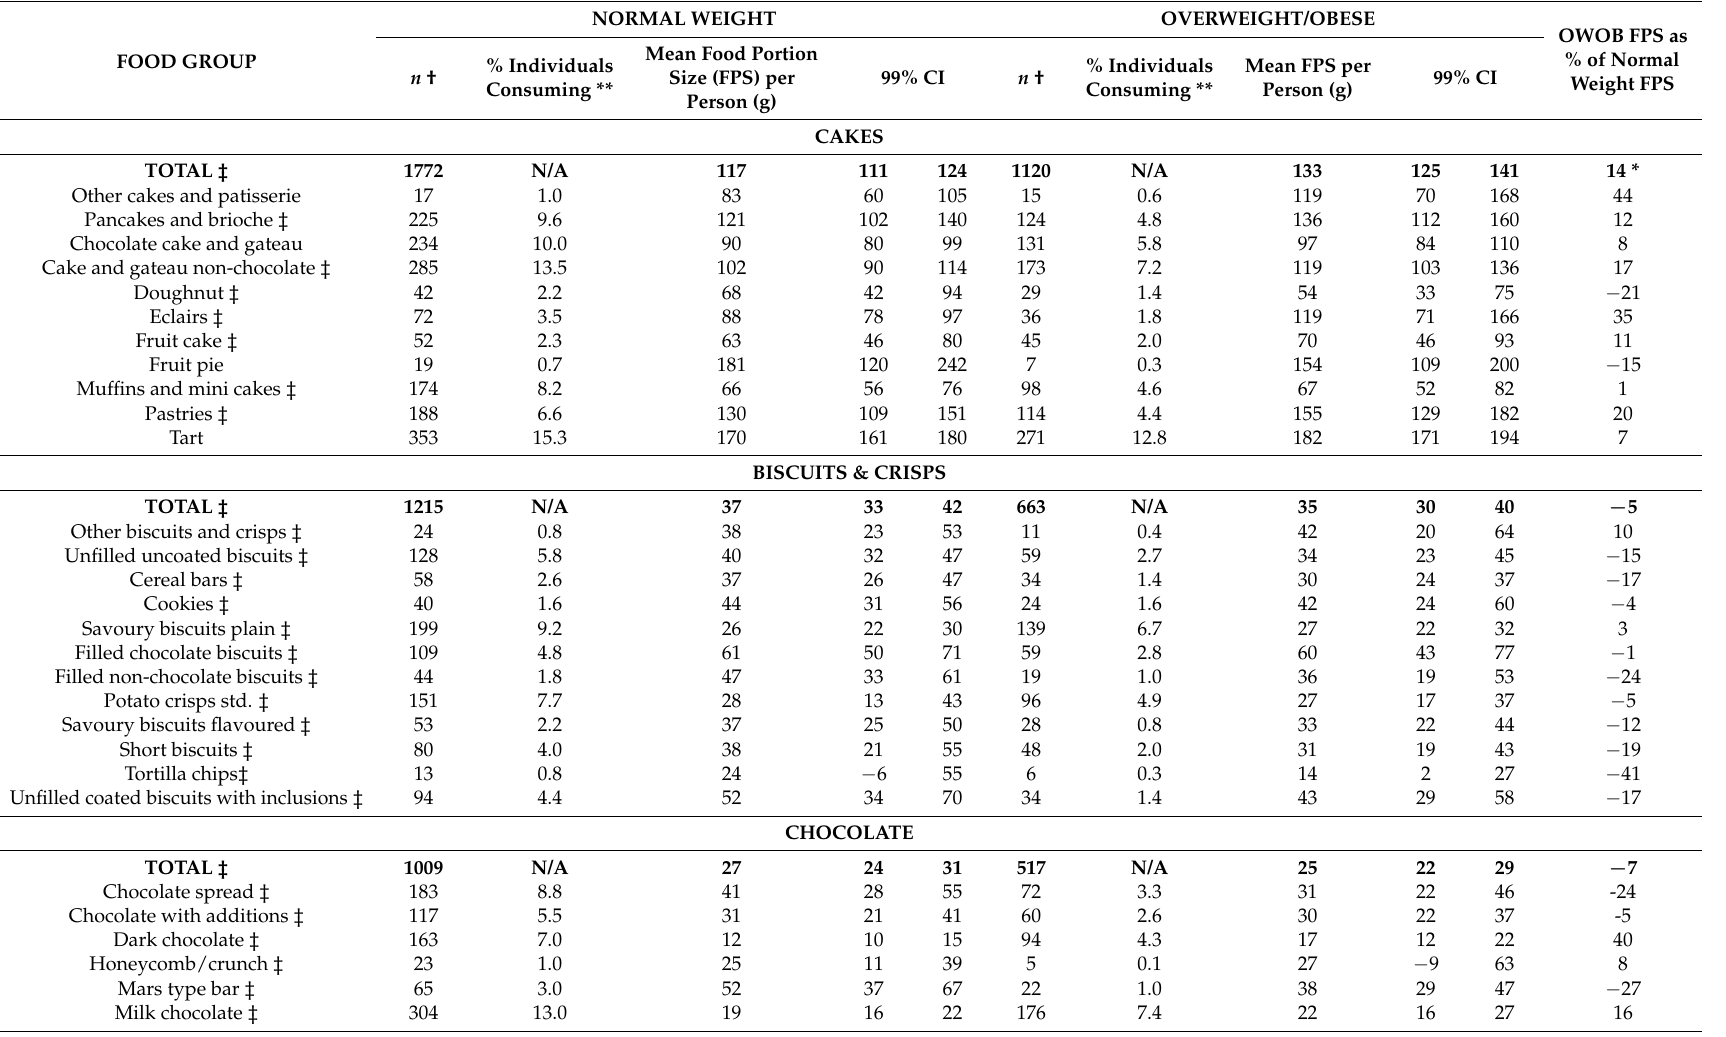
Table 2. Mean portion size of energy-dense foods by BMI status for consumers aged 19–64 years in the French